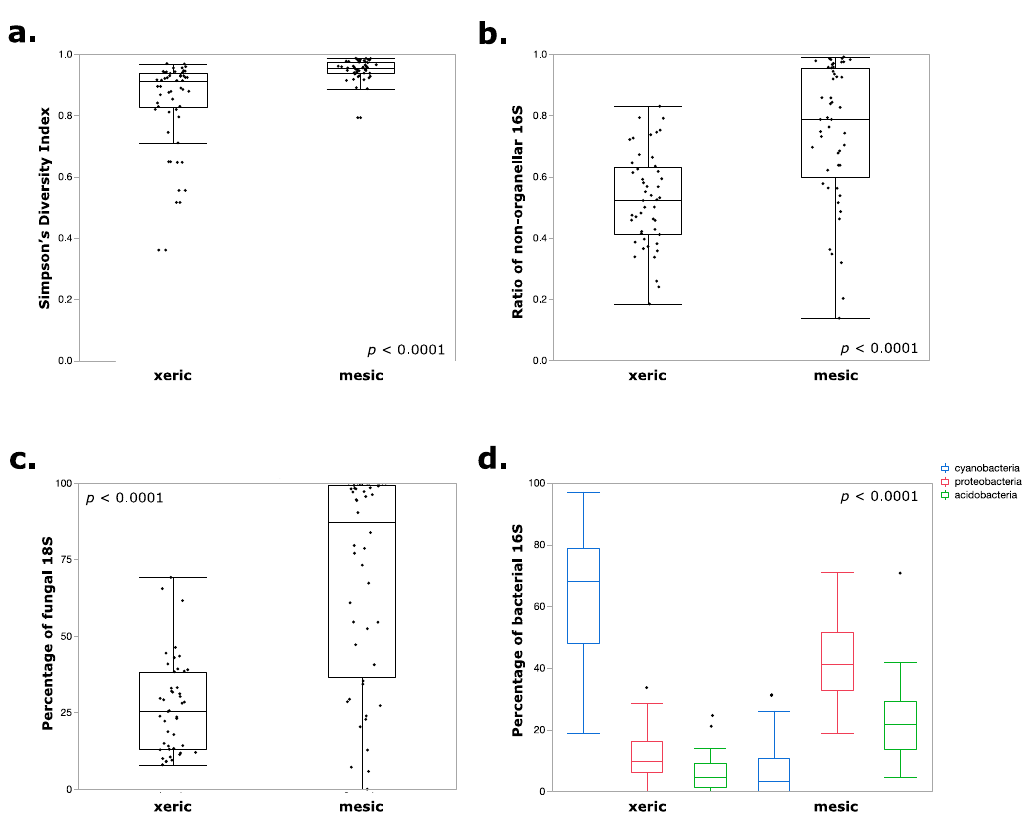
Figure 5. Comparisons between xeric and mesic and semi-xeric samples. ( a ) Simpson’s diversity index distribution calculated for bacterial amplicon abundances. The xeric samples were much less diverse than the mesic samples. ( b ) The xeric samples contained a large amount of organellar 16S rDNA (both from chloroplasts and mitochondria), with as much as 50% on average, even with the presence of inhibitory PNAs. Together with the lower Simpson’s diversity, these results suggest a limited bacterial population within xeric mosses. ( c ) Fungi was highly abundant in mesic samples, whereas ( d ) Cyanobacteria was much more abundant in xeric mosses, and the mesic samples contained more Proteobacteria and Acidobacteria. All of the comparisons between xeric and mesic samples were significant ( p < 0.0001) in two-tailed Student’s t-tests.